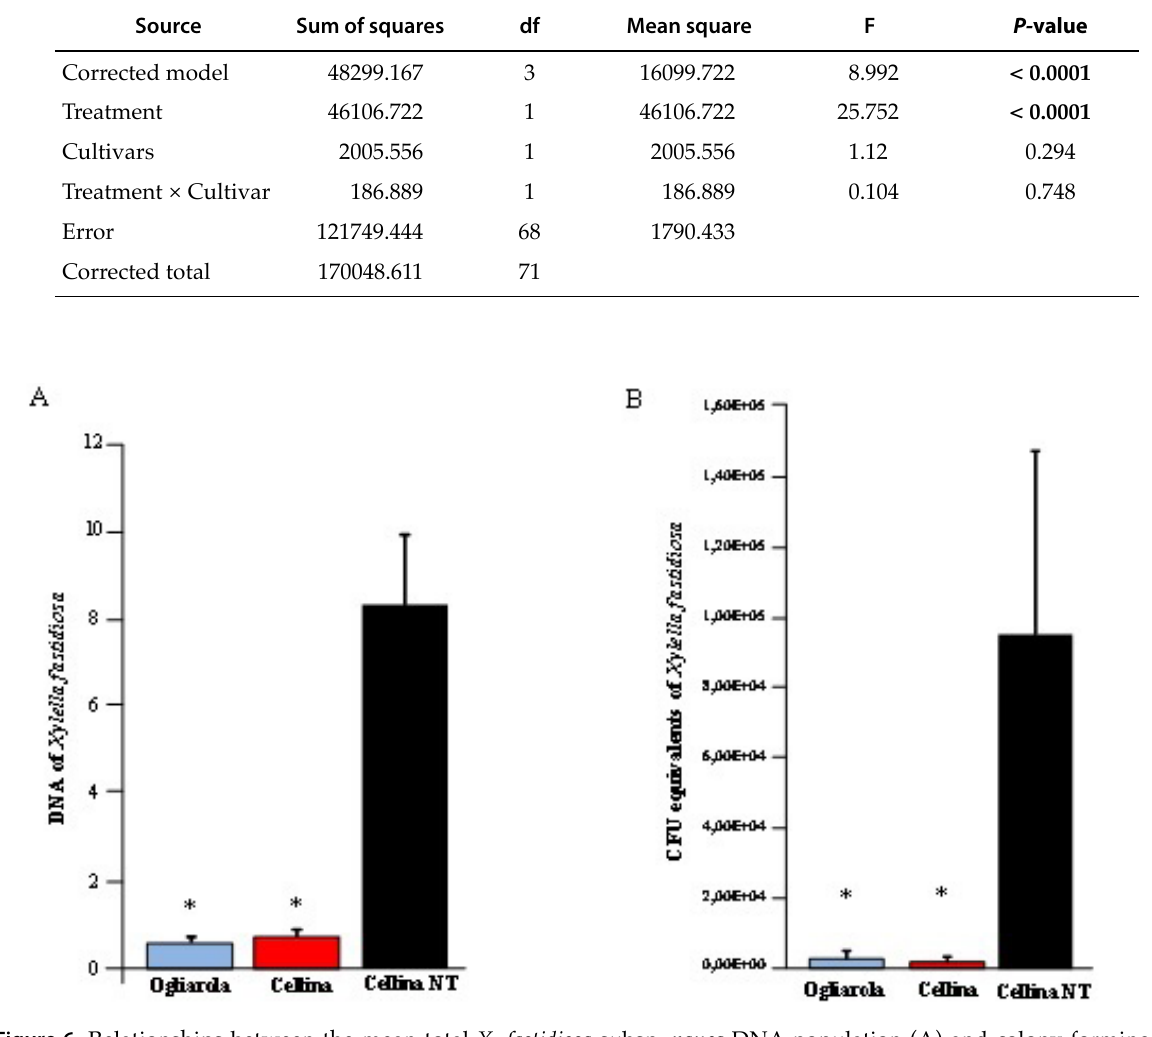
Figure 6. Relationships between the mean total X. fastidiosa subsp. pauca DNA population (A) and colony forming unit (CFU) equivalents (B), calculated following Modesti et al . (2017), determined for Dentamet®-treated (cv. Ogliarola salen- tina and Cellina di Nardò) and untreated control (cv. Cellina di Nardò) olive trees. NT: not treated. Data refer to the trees still alive at the end of the trial, where a cv. Ogliarola salentina control tree was dead on December 2016. *: statistically significant value compared with the untreated tree ( P <0.05). Bars represent standard errors of means.